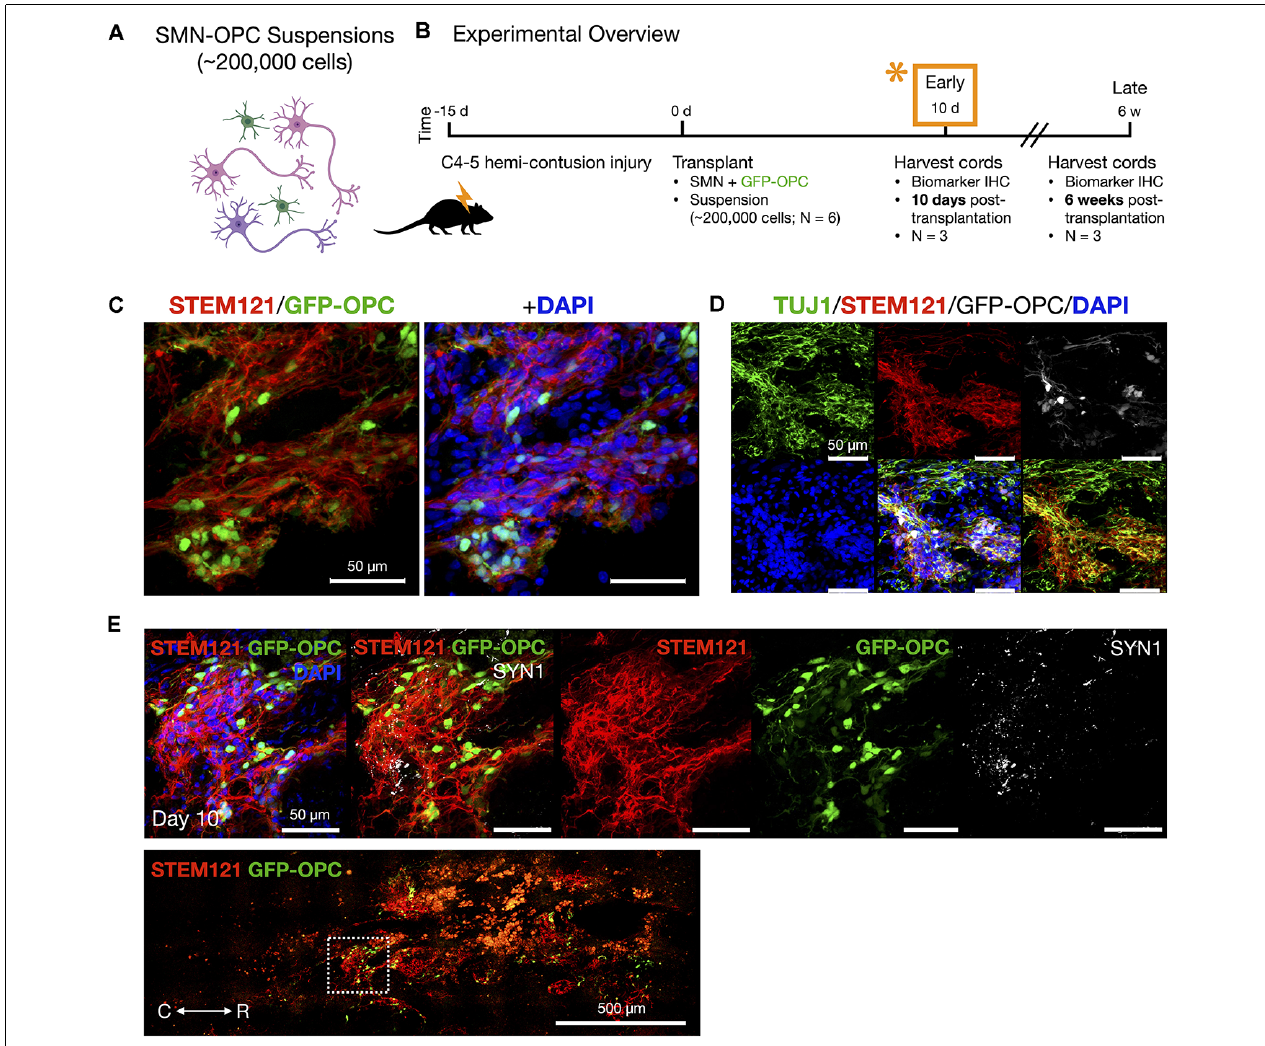
FIGURE 4 | In vivo delivery of SMN-OPC cell suspensions into the contusion cavity and survival at 10 days post-transplantation. (A) Schematic overview of the SMN-OPC cell suspension grafts. Pink depicts spinal motor neurons, purple depicts spinal interneurons that co-differentiate, and green is GFP-OPCs. (B) Schematic overview of SMN-OPC cervical hemicontusion grafting experiment ( N = 6 animals). ∗ Data provided in this figure are from the 10 days time point. (C) STEM121/GFP-OPC/DAPI merged image at the 10 days time point. (D) TUJ1 immunostain validates retention of the neuronal phenotype since this antibody detects the neuron-specific β -tubulin isotype, β -III-tubulin. (E) High magnification image of suspension SMN and GFP-OPC survival 10 days post-transplantation. SYN1 co-localization with STEM121 is shown. Low magnification STEM121/GFP-OPC image denotes position of field acquired caudal to the lesion epicenter (white box). R (rostral), C (caudal). Individual scale bars are